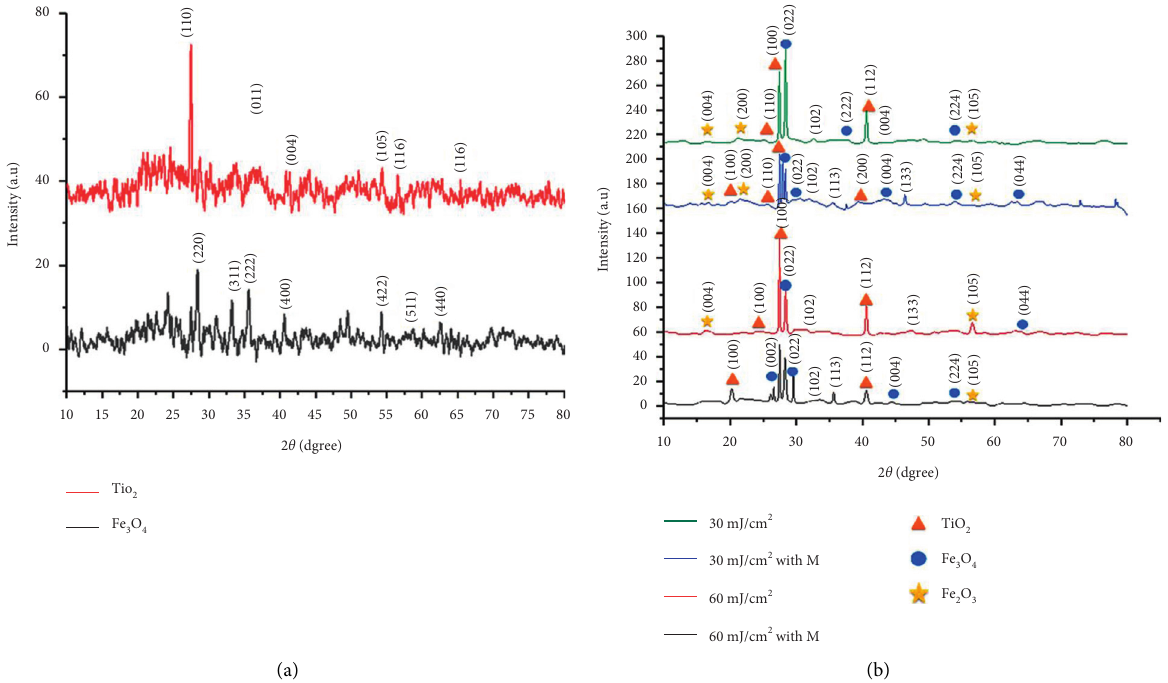
Figure 2: (a) XRD patterns of the NPs prepared by LASER ablation in liquid medium with a LASER fluence of 60mJ/cm 2 and (b) XRD patterns of the NPs prepared by LASER ablation in liquid medium with a LASER fluence of 30mJ/cm 2 and 60 mJ/cm 2 without and with the presence of the magnetic fields. The XRD peaks located at 2 θ of 31.7 ° , 35.6 ° , and 47.3 ° , corresponding to (102), (113), and (133) planes, were assigned for the TiFe 2 O 5 phase. M stands for the magnetic field.